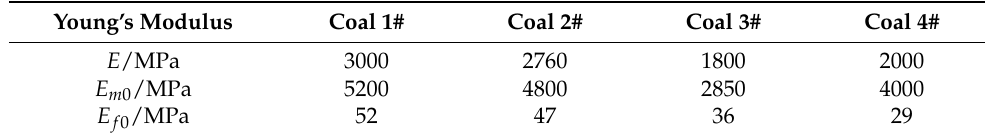
Table 4. Coal moduli for the numerical research on model sensitivity.